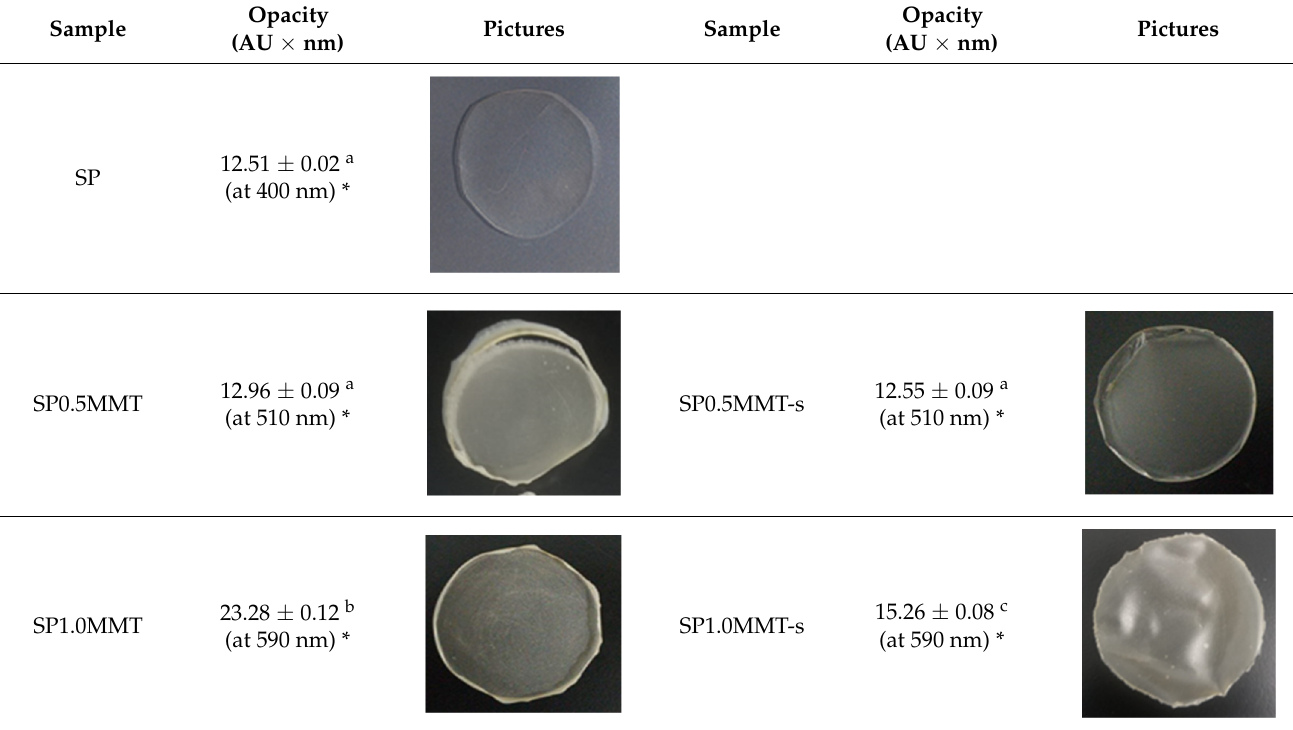
Figure 3. SEM micrographs for biodegradable films with MMT nanoclay at 5000× magnification. ( a ) SP1.5MMT and ( b ) SP1.5MMT-s.